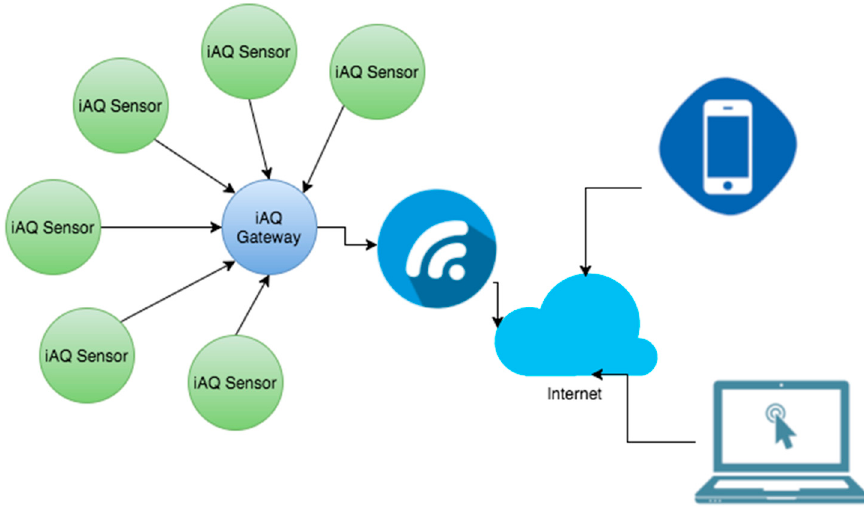
Figure 5. iAQ system architecture.